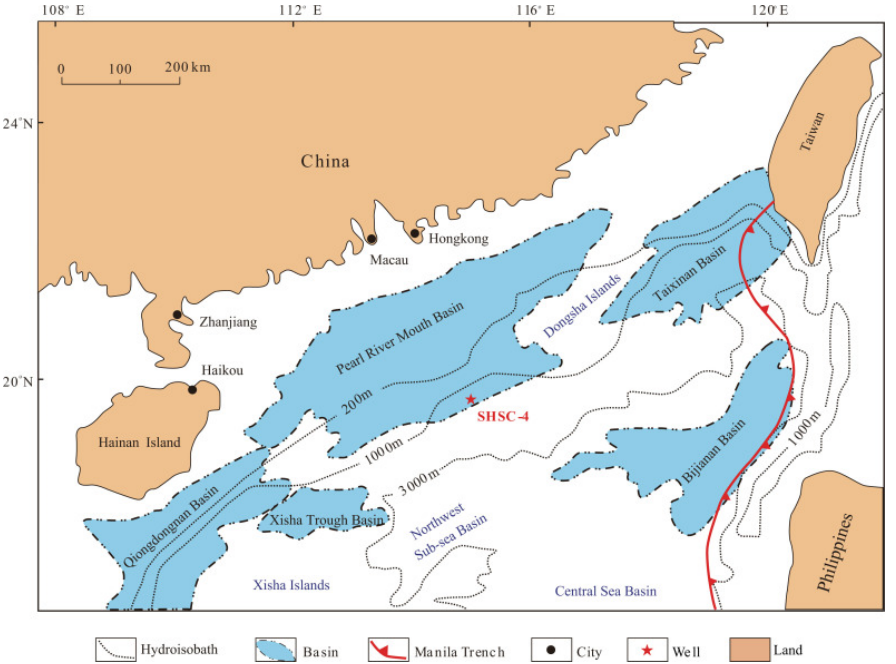
Figure 1. Trial production location of natural gas hydrate from the reservoir in the Shenhu sea area, South China Sea [25].